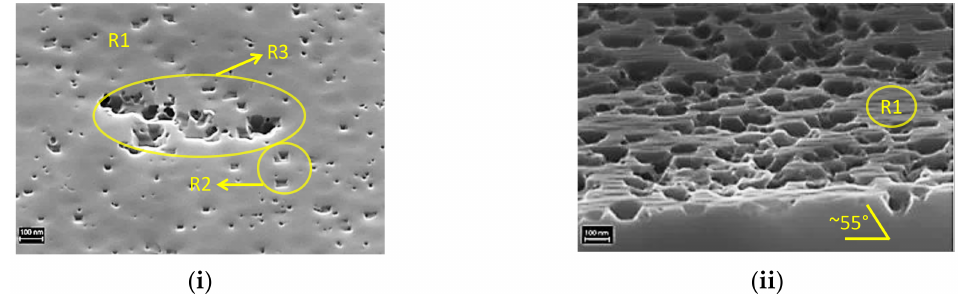
Figure 10. SEM images showing etch initiations in freshly cleaned Si(100) surface after etching with a velocity of ( i ) 6.5 mm / s, and ( ii ) 3.5 mm /